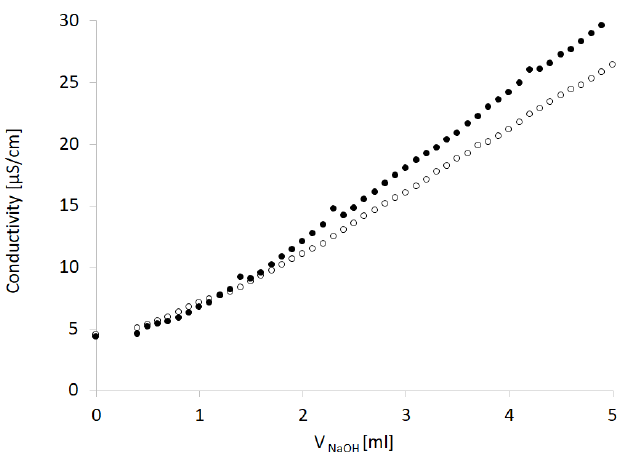
Figure 10. Effect of the addition of 3.3% ethanol (black dots) to the NaOH aqueous solution (empty dots) on the conductivity assessed in the titration procedure.